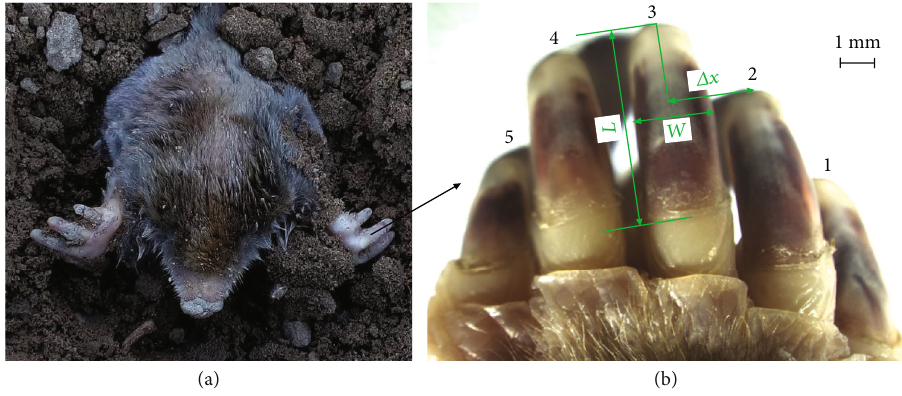
Figure 2: (a) A mole rat and (b) the fi ve fore claws.